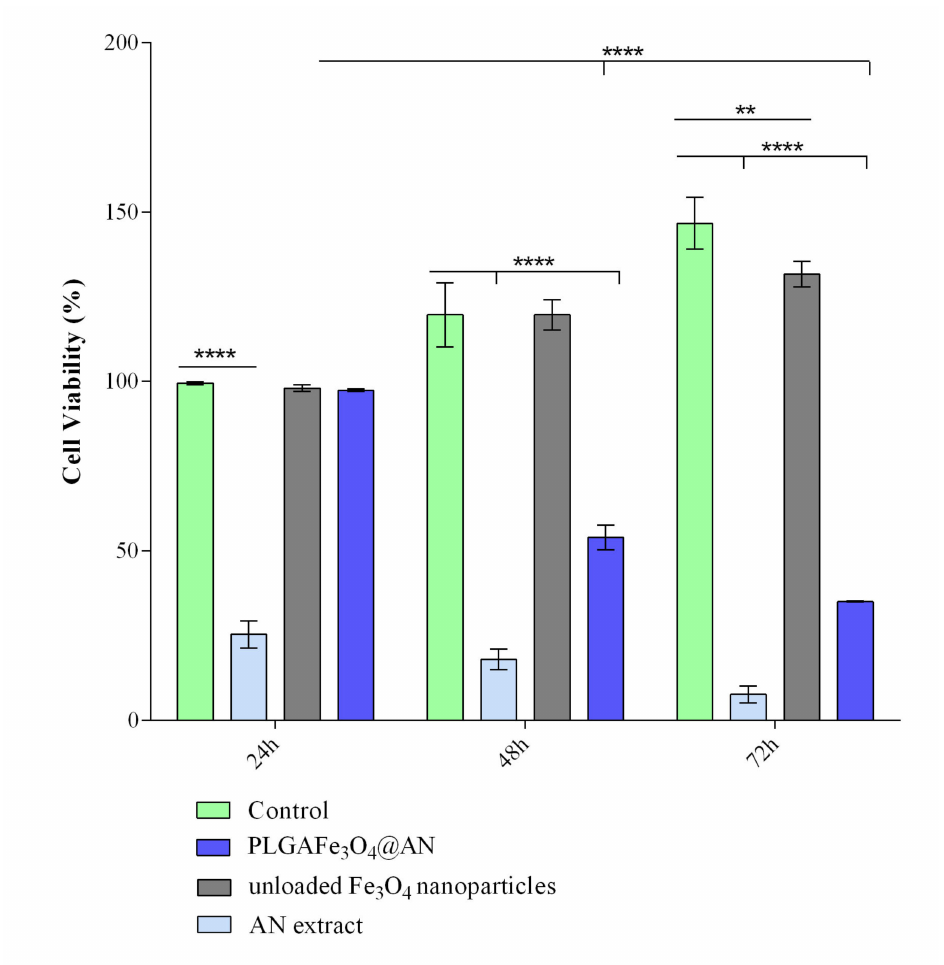
Figure 5. Cell viability of human adenocarcinoma HT-29 cells after 24, 48, and 72 h of contact with the PLGA–Fe 3 O 4 @AN coatings, as revealed by the MTT assay (** p ≤ 0.01, **** p ≤